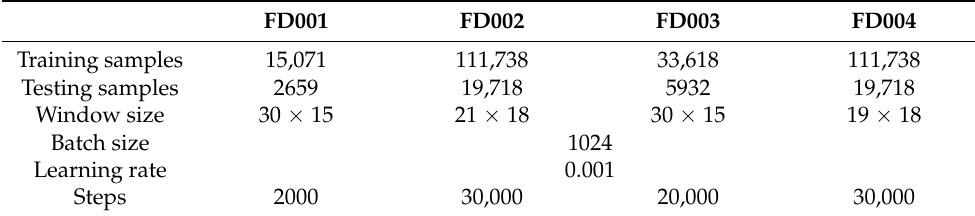
Table 9. Overview of the training parameters proposed and obtained from validation.